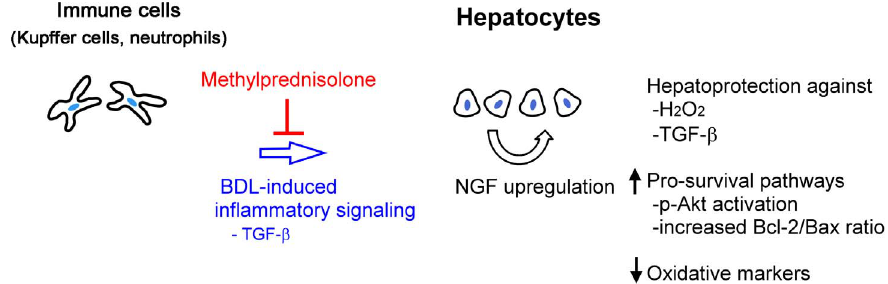
Figure 9. Hypothetical scheme showing the regulatory mechanisms and hepatoprotective roles of NGF. When the liver encounters BDL-induced cholestatic injury, inflammatory signals will induce NGF up-regulation, which can be blocked by systemic MP administration. In vitro study shows that TGF- b 1 may be one of the upstream molecules that induce NGF expression in parenchymal hepatocytes. NGF is able to (1) ameliorate hepatocyte cell death caused by exogenous hydrogen peroxide and TGF- b 1, (2) enhance pro-survival pathways, including p-Akt and Bcl-2/ Bax ratio, (3) decrease intracellular oxidative adduct formation.